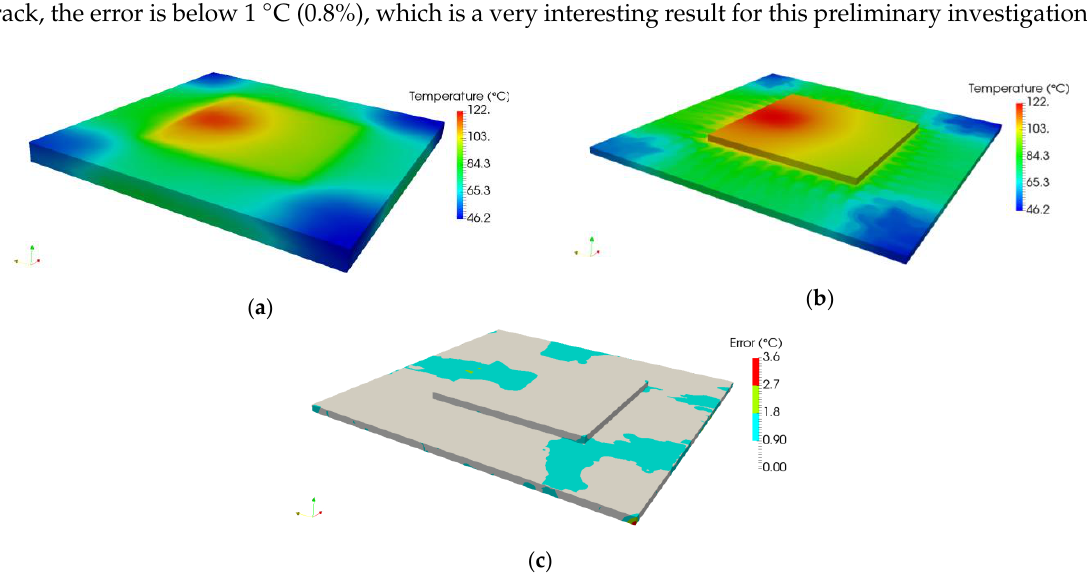
Figure 10. Temperature field with molded resin ( a ), without ( b ), and error field ( c ) at steady state for Test 1.